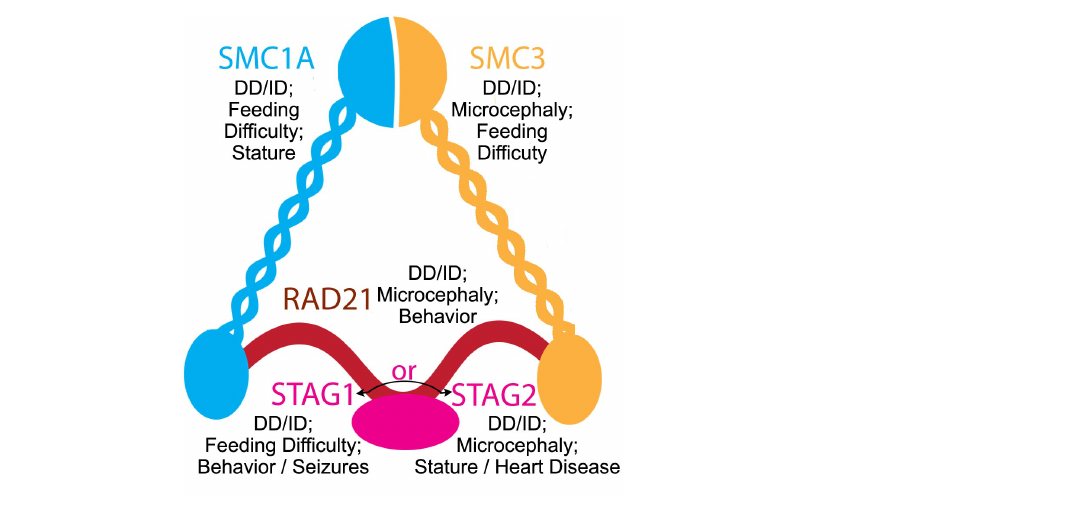
Figure 5. Cohesin subunits and the most frequently reported phenotypes associated with mutations in patients, as described